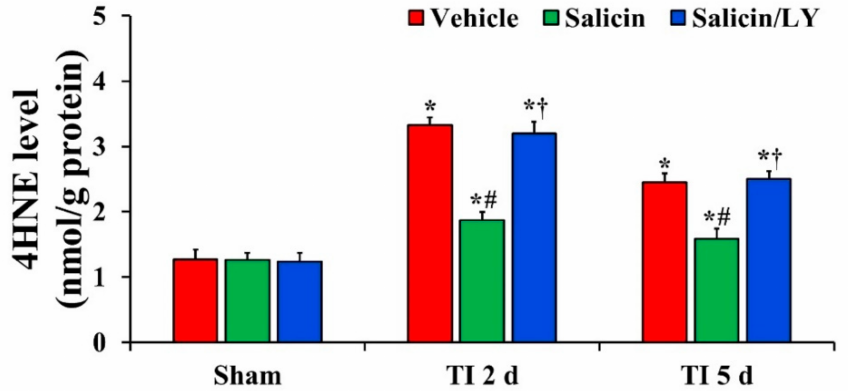
Figure 3. Level of 4HNE in the vehicle-treated, salicin-treated, and salicin/LY-treated groups at sham, 2 days, and 5 days after TI. In the salicin-TI group, 4HNE level is significantly reduced compared with that at the corresponding time of the vehicle-TI group. However, in the salicin/LY-TI group, 4HNE level is similar to that in the vehicle-TI group. The bars indicate the means ± SEM ( n = 5 at each time, * p < 0.05 vs. each sham group, # p < 0.05 vs. vehicle-TI group, † p < 0.05 vs. salicin-TI group; the vehicle-sham group was regarded as control